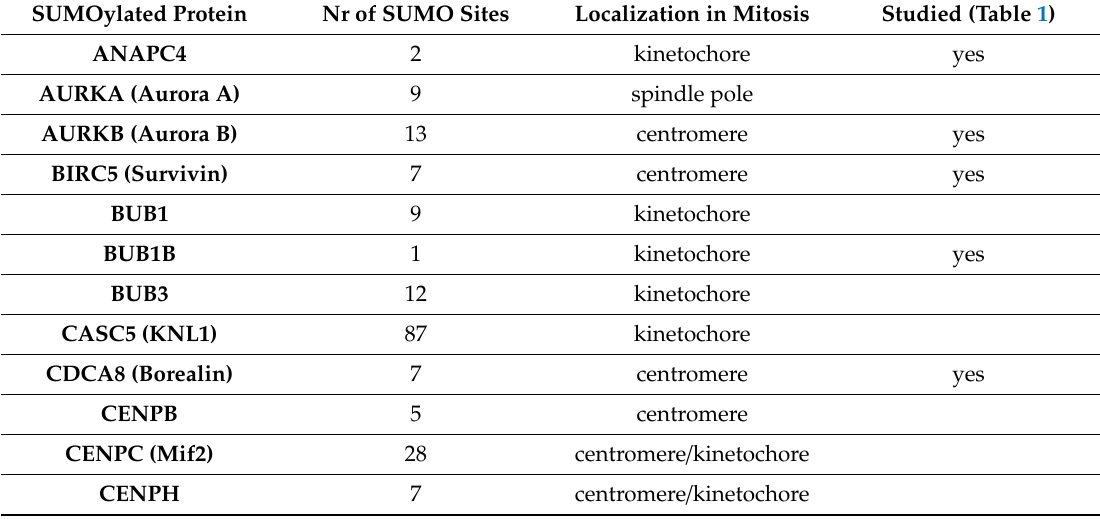
Table 2. Examples of interesting SUMOylated spindle proteins from the Supplementary Table 2 in [34]. These include proteins from Table 1, supplemented with a non-exhaustive list of mitotic proteins. SUMOylated Protein Studied (Table